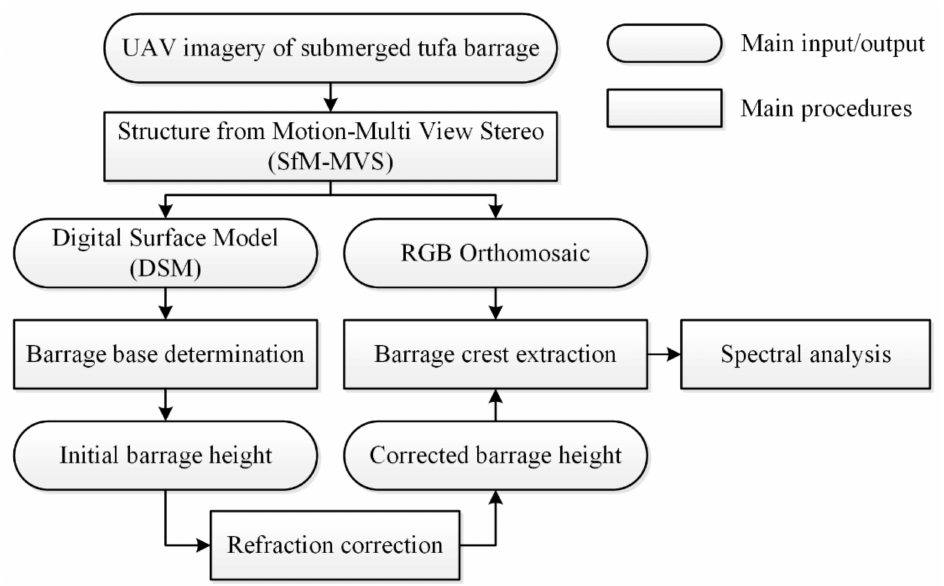
Figure 3. Flowchart for processing UAV images of the submerged tufa barrage.